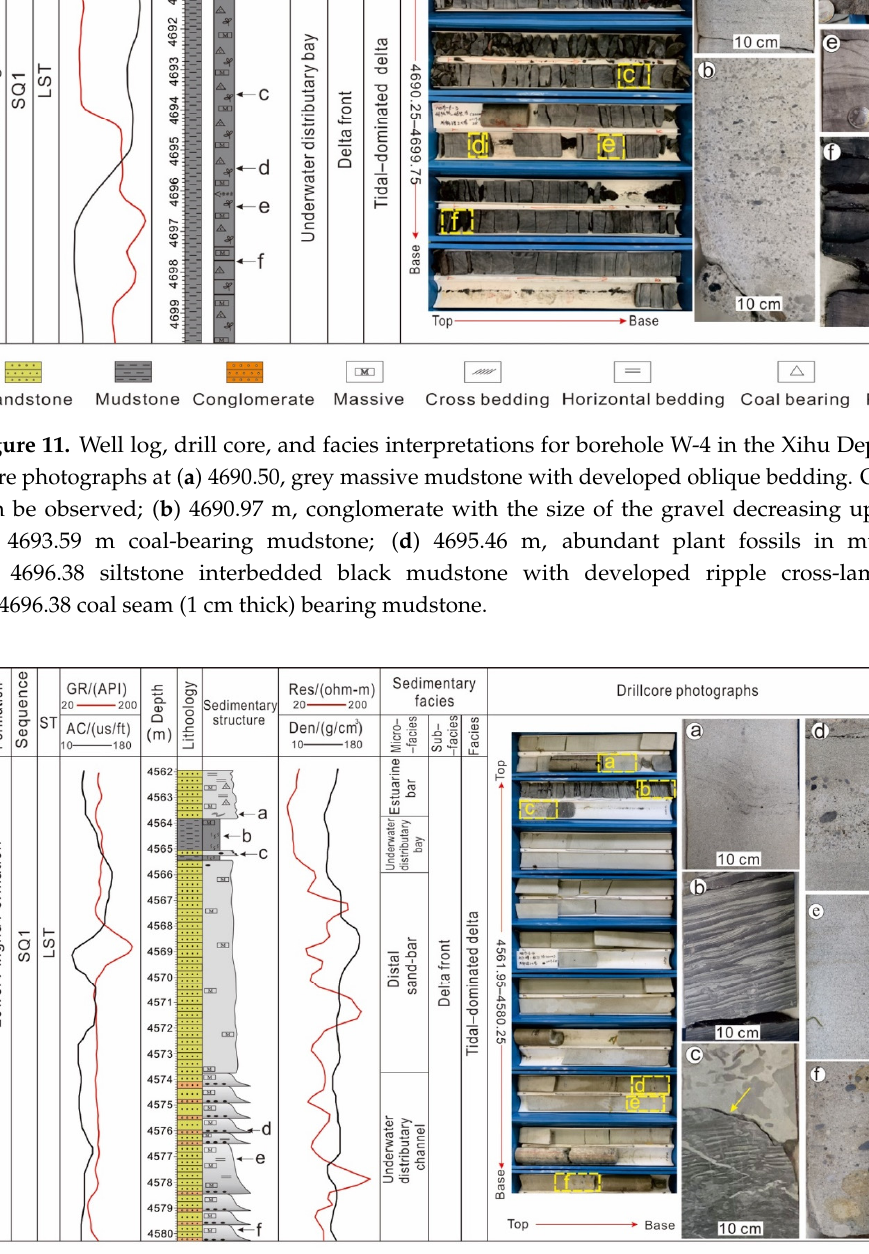
Figure 12. Well log, drill core, and facies interpretations for borehole W-5 in the Xihu Depression. Core photos ( a ) 4563.64 m, massive sandstone with deformed structure; ( b ) 4564.5 m, interbedded siltstone and mudstone with ripple cross lamination; ( c ) 4565.17 m, contacting surface of mudstone and sandstone. Mudstone breccia is observed in sandstone with a fracture developed in the mudstone; ( d ) 4576.00 m, scouring surface, the contacting surface of conglomerate and sandstone; ( e ) 4577.10 m, grey massive sandstone with faint parallel bedding; ( f ) 4579.86, conglomerate-bearing sandstone. The rounding and sorting of the gravel are good. Size ranges from 0.5 cm to 3 cm.